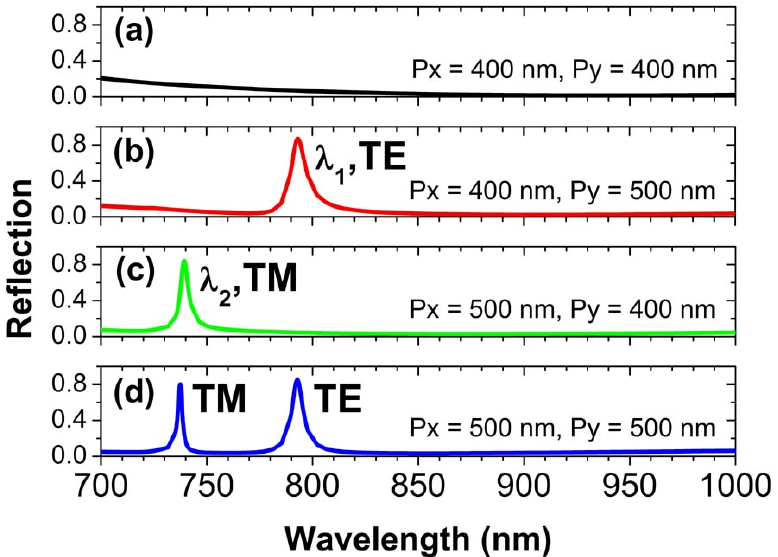
Figure 2. The reflection spectra of normally incident light for the array periods of Au spheres to be changed. ( a ) For the array periods p x = 400 nm and p y = 400 nm; ( b ) For the array periods p x = 400 nm and p y = 500 nm; ( c ) For the array periods p x = 500 nm and p y = 400 nm; ( d ) For the array periods p x = 500 nm and p y = 500 nm.